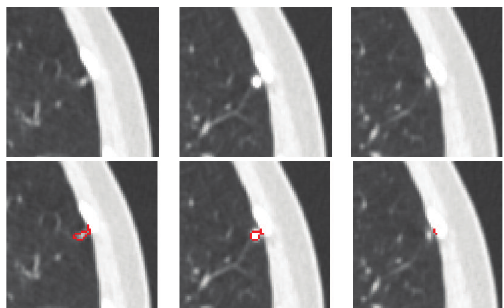
Figure 18: Example of a pleural nodule segmentation. Top row: original 3D nodule on three contiguous slices; bottom row: segmentation results based on the proposed method for which a small part of nodule on the last slice was incorrectly segmented.